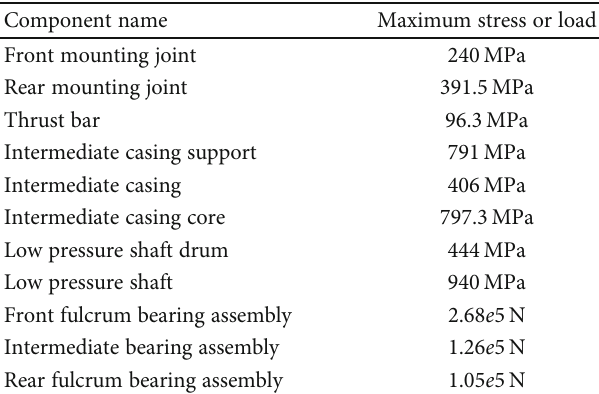
Figure 16: Contact force variation of bearing Table 7: Response of key components in engine bird ingestion.